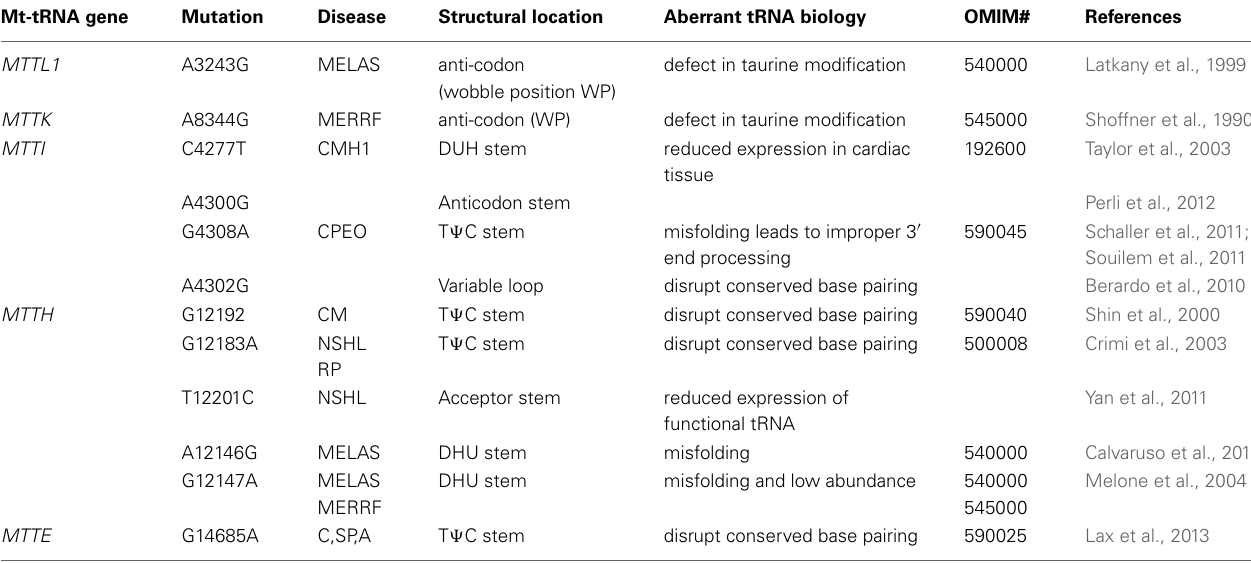
Table 1 | Mitochondrial tRNA mutations and disease. Mt-tRNA gene